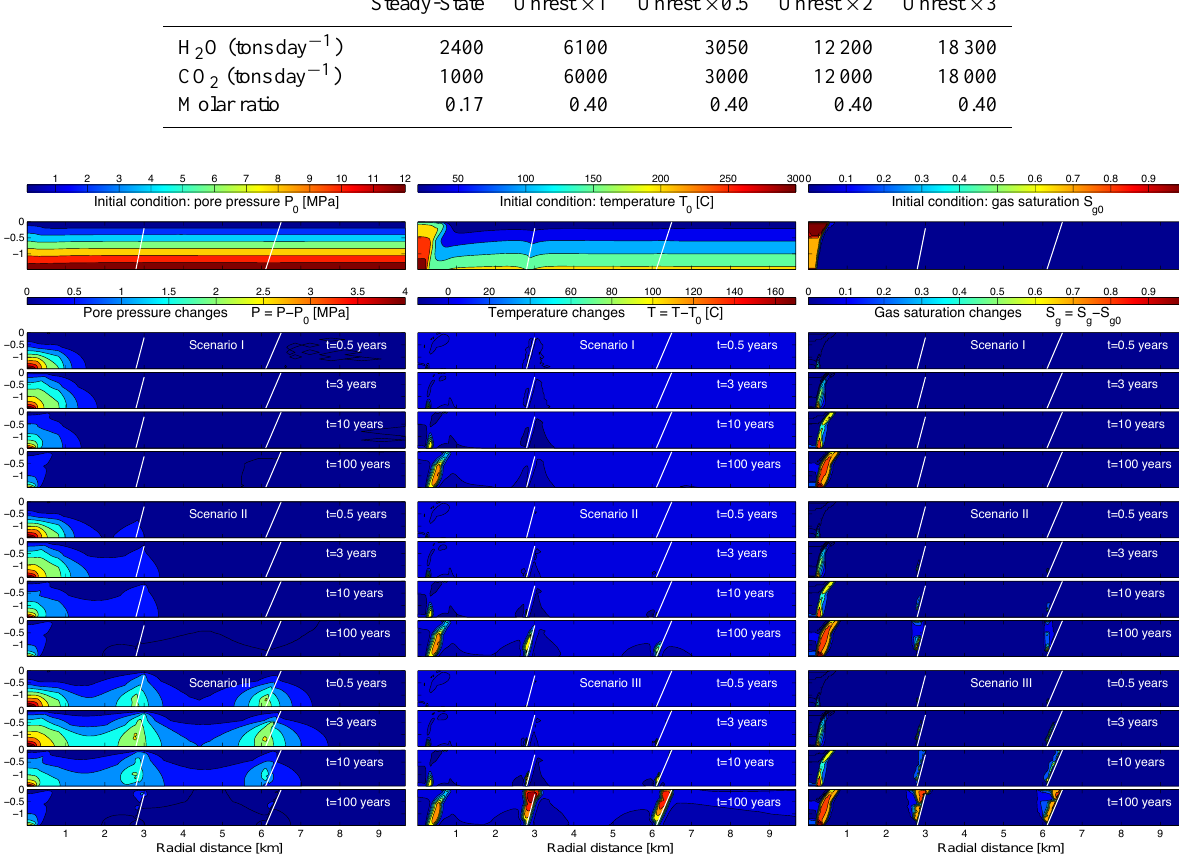
Figure 5. Changes in pore pressure, temperature and gas saturation relative to the steady-state initial condition at different times after the initiation of unrest. Initial conditions are obtained as the steady-state solutions of central injection of 2400 of H 2 O and 1000tonsday − 1 of CO 2 , through a cylindrical conduit with radius 200m. Unrest is simulated by injecting 6100 of H 2 O and 6000tonsday − 1 of CO 2 through the central conduit (Unrest × 1 column of Table 4) and additionally for Scenarios II and III injecting at the base of the core zone of the two faults according to Table 3. Note that the colour scale of initial conditions is different from the respective colour scale of unrest plots.